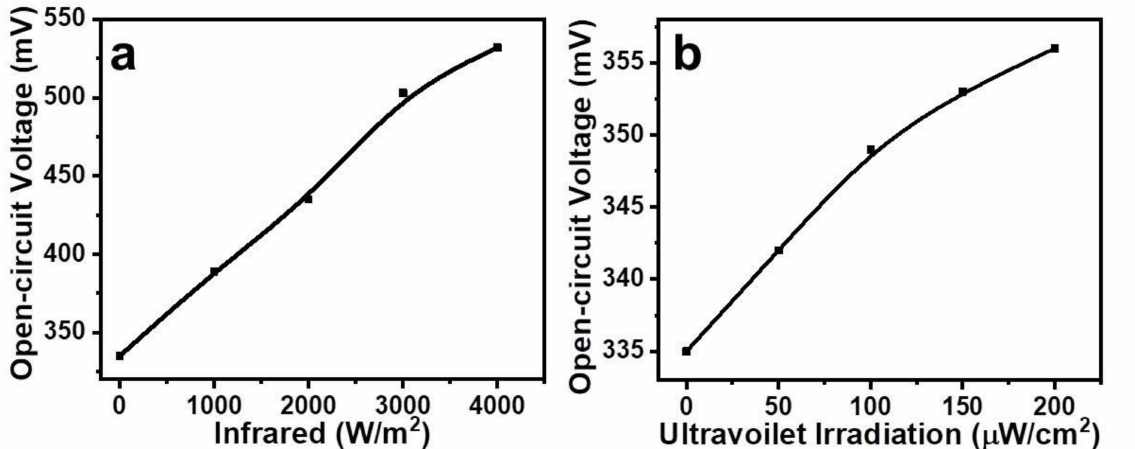
Figure 5. Open-circuit voltage-infrared irradiation ( a ) and open-circuit voltage-ultraviolet irradiation ( b ) relationships of Al/OD-Gel/Cu